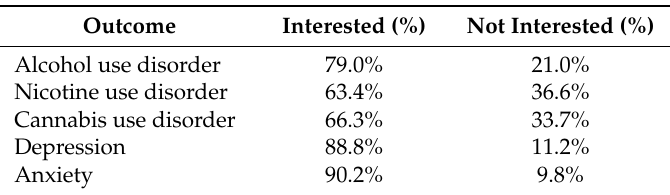
Table 1. Frequencies of interest in receiving genetic feedback for the five substance use and psychiatric conditions in the full sample.